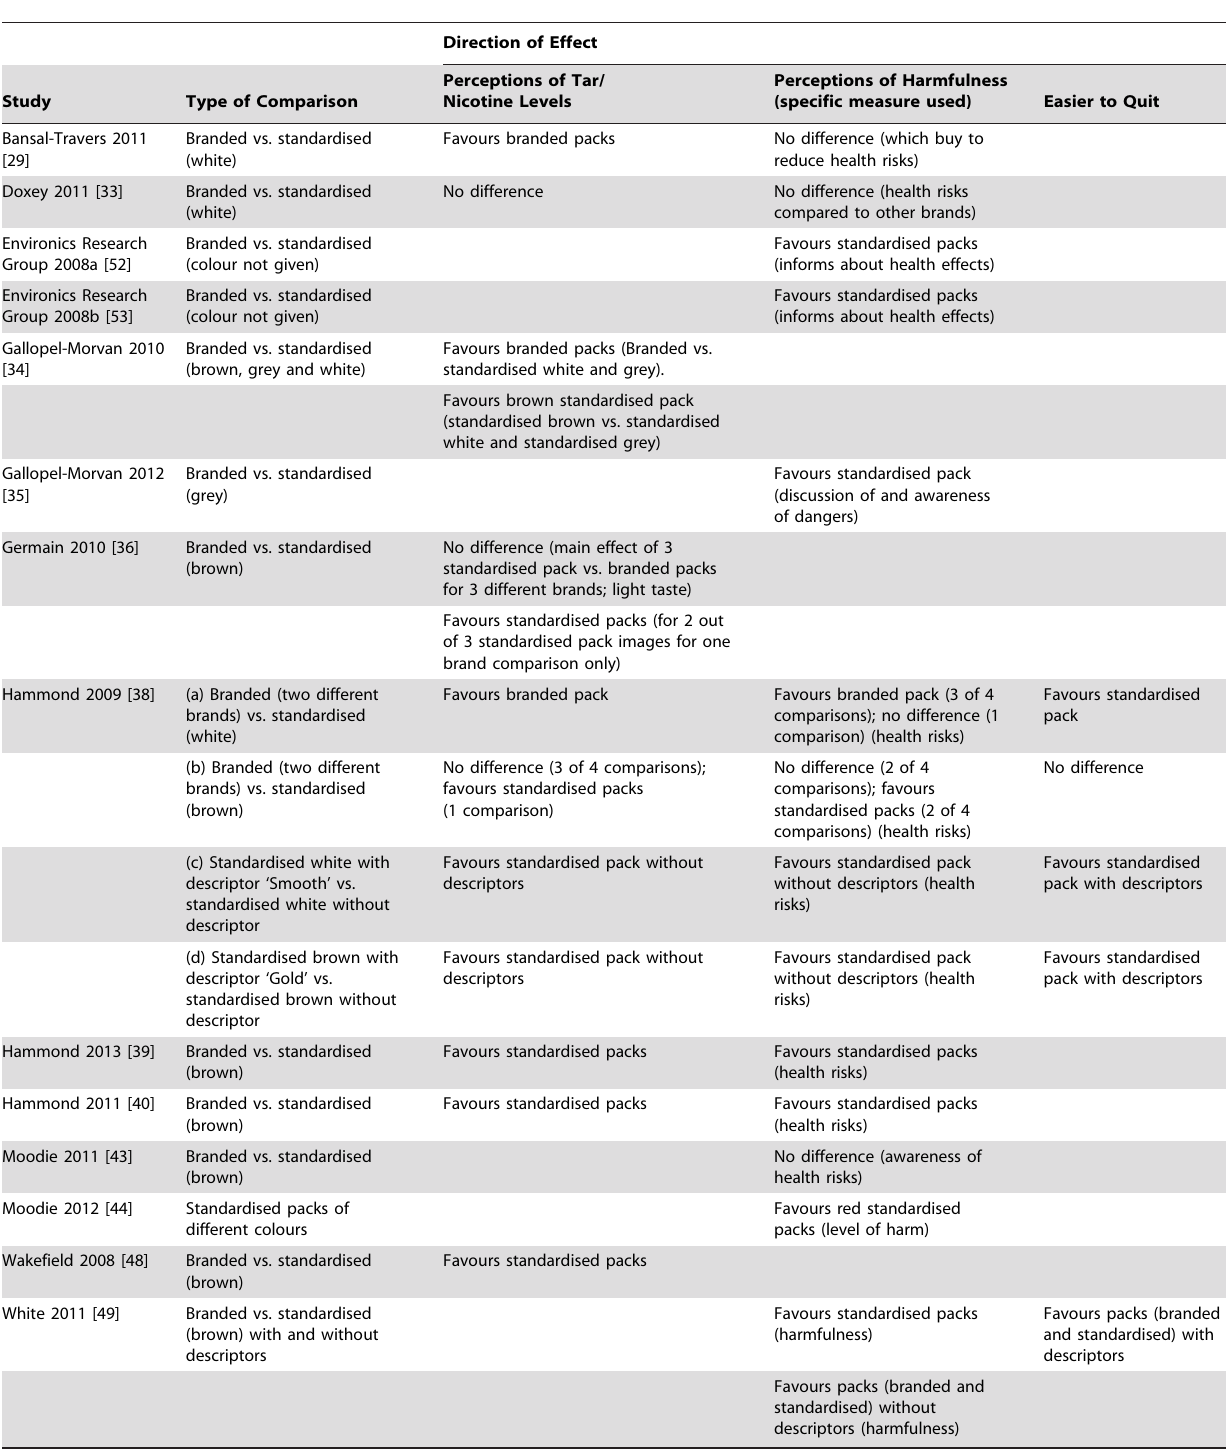
Table 3. Direction of effect: Perceptions of strength, harmfulness and which packs are easier to quit.